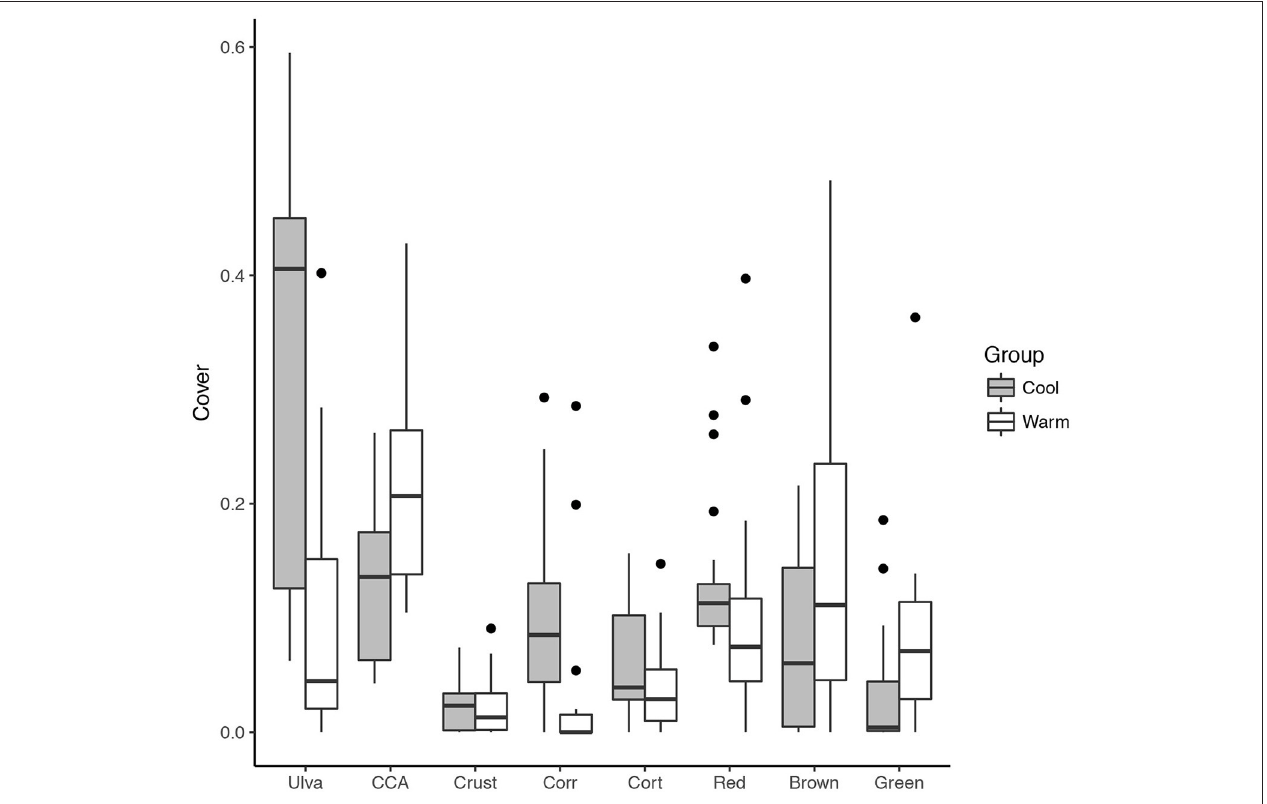
FIGURE 5 | Comparison of the coverage of major benthic groups between “cool” ( < 24 ◦ C, n = 21) and “warm” ( < 24 ◦ C, n = 17) sampling periods. Algal groups are shown on the X-axis as Ulva , CCA, crustose, corticated, and filamentous, which are grouped as Red ( Centroceras spp., Ceramium spp., Polysiphonia spp.), Green ( Bryposis spp., Chaetomorpha antennina ), and Brown ( Ectocarpus spp.). between the Akaike Information Criterion (AICc, for small sample sizes) of each model and the minimum AIC.